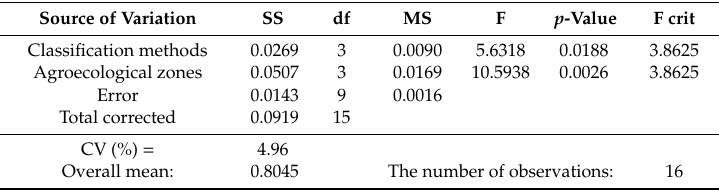
Table A2. Summary of the analysis of variance computed for the OA.